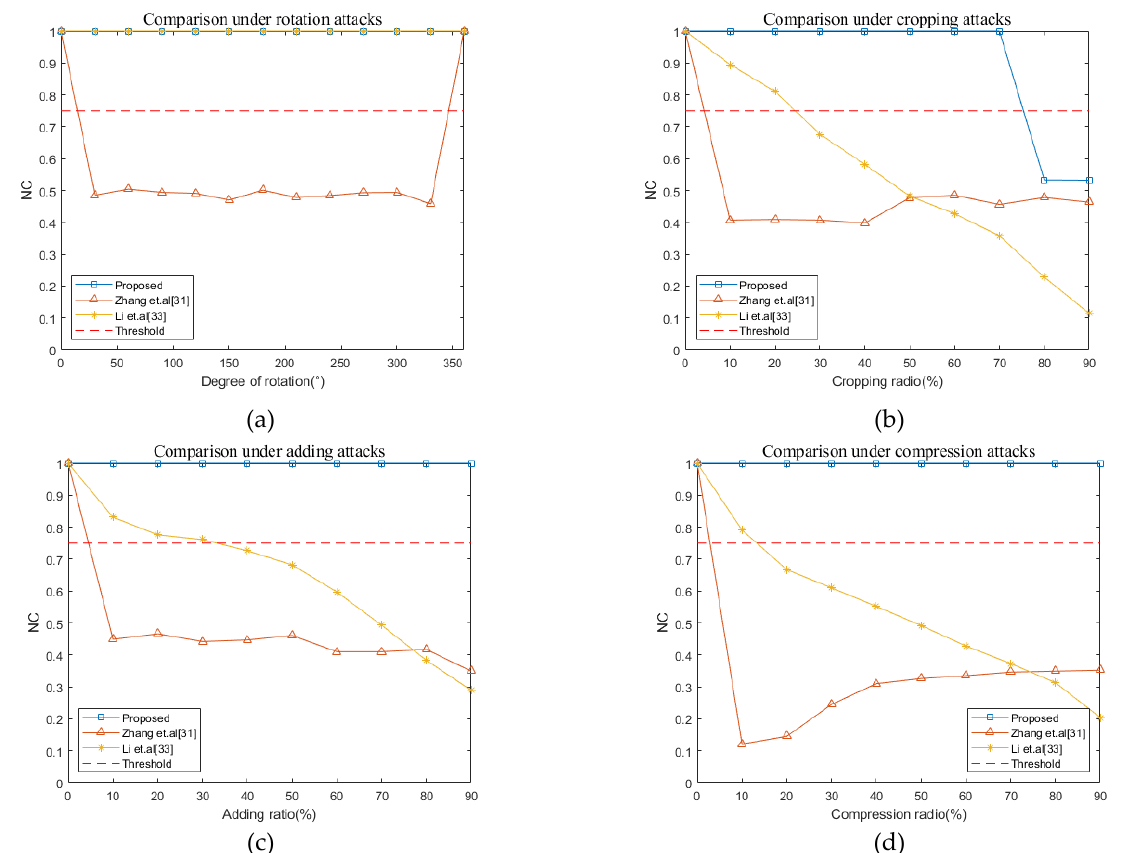
Figure 13. Comparison of algorithm robustness under different watermark attacks. (a) Comparison under a rotation attack. (b) Comparison under a cropping attack. (c) Comparison under an adding attack. (d) Comparison under a compression attack.